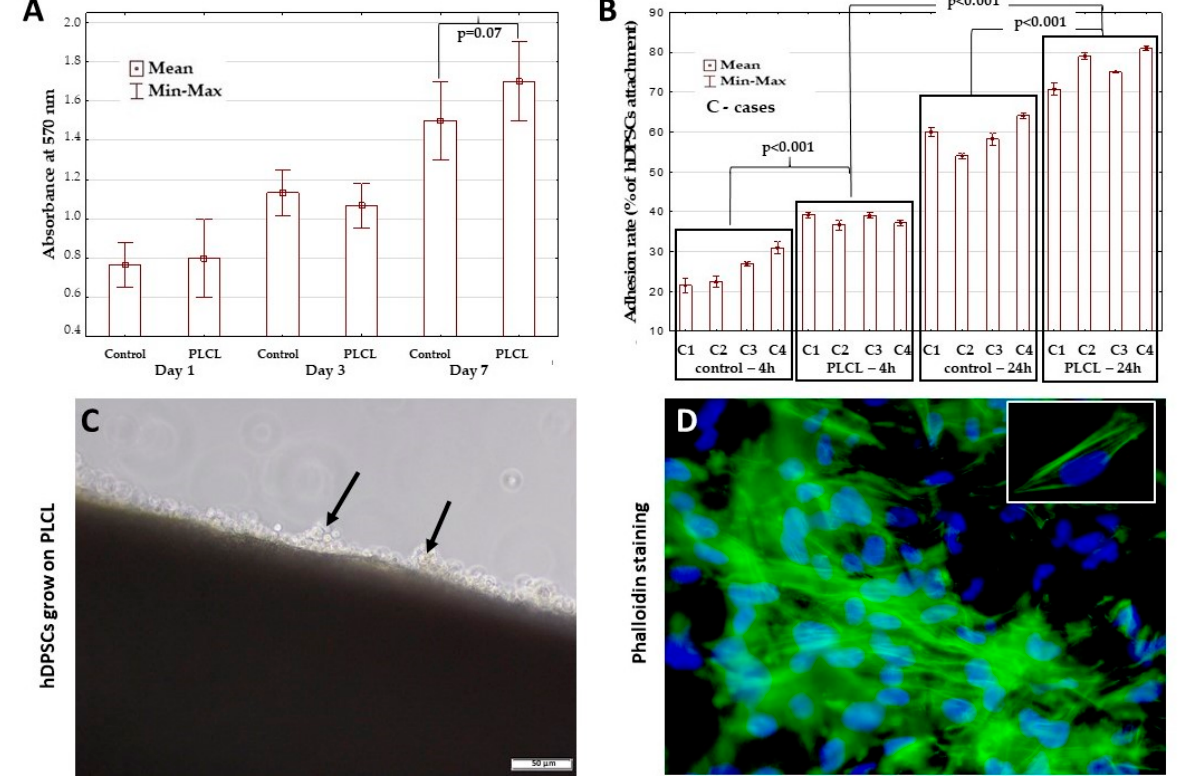
Figure 4. Viability and adhesion of hDPSCs grown on PLCL. ( A ) MTT assay results for hDPSCs grown on PLCL and as a monolayer culture (control) after one, three and seven days of culture. Borderline differences were found between the control group and the hDPSCs grown on PLCL on day seven of culture ( p = 0.07). ( B ) adhesion rate of hDPSCs cultured on the PLCL nanofibrous scaffold was significantly higher compared to the control group at 4 and 24 h. Data are expressed as the mean ± SD ( n = 4). ( C ) adhesion of hDPSCs seeded on the surface of PLCL (arrows) after 24 h of culture observed under inverted light microscopy. ( D ) Immunofluorescence staining of hDPSCs grown on PLCL scaffold by using Alexa Fluor 488 conjugated phalloidine is shown in green. Nuclei counterstained with DAPI are shown in blue. Actin structures are visible in the majority of cells growing on PLCL. In the white rectangle, there is a single enlarged hDPSC cell documenting the expression of actin. Scale bar = 50 μ m ( C ) and magnification ×600 ( D ).